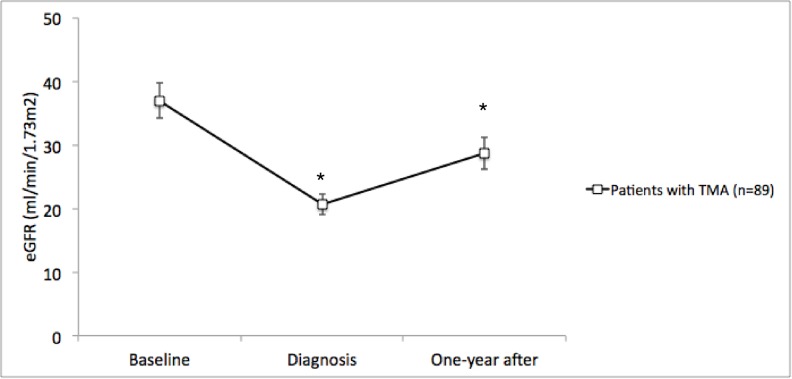
Allograft function of kidney-transplanted patients with TMA at baseline, TMA diagnosis and after one-year of follow-up (n = 89).A statistically significant drop of mean eGFR±SE occurred at diagnosis (Baseline vs. Diagnosis, p<0.001), which was permanent until the end of the study (Diagnosis vs. One-year after, p = 0.13; Baseline vs. One-year after, p<0.001). Baseline eGFR was calculated with the lowest serum creatinine level in up to 3 months before TMA diagnosis and patients with graft failure were considered to have an eGFR of 5 ml/min/1,73m2. * means p< 0.05 in relation to baseline eGFR. TMA = Thrombotic microangiopathy; eGFR = estimated glomerular filtration rate; SE = standard error.